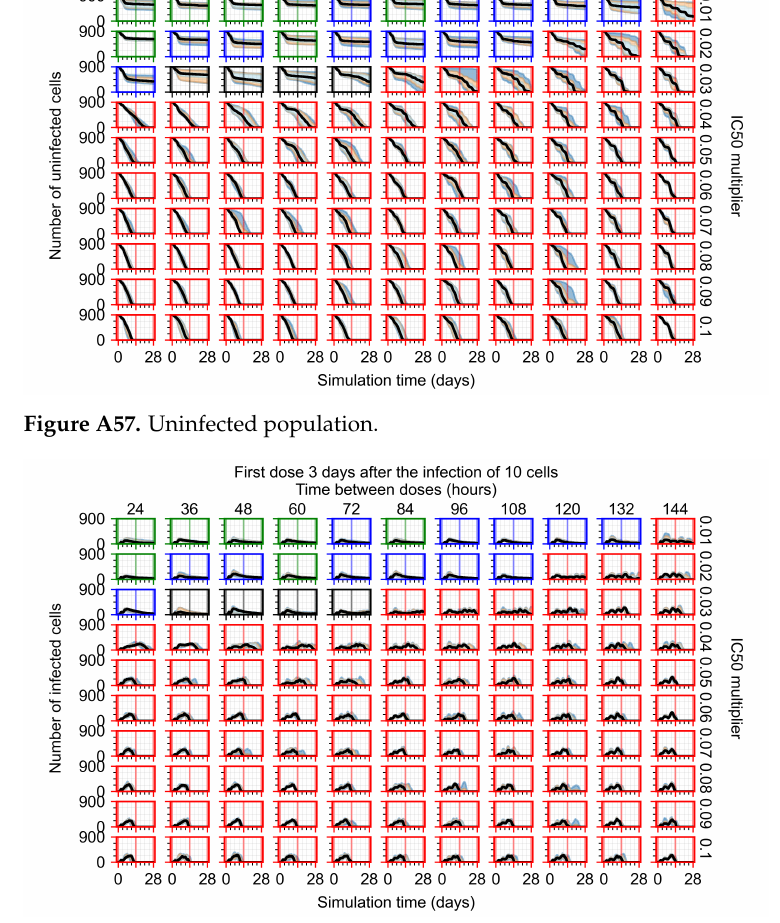
Figure A58. Infected (eclipse phase)